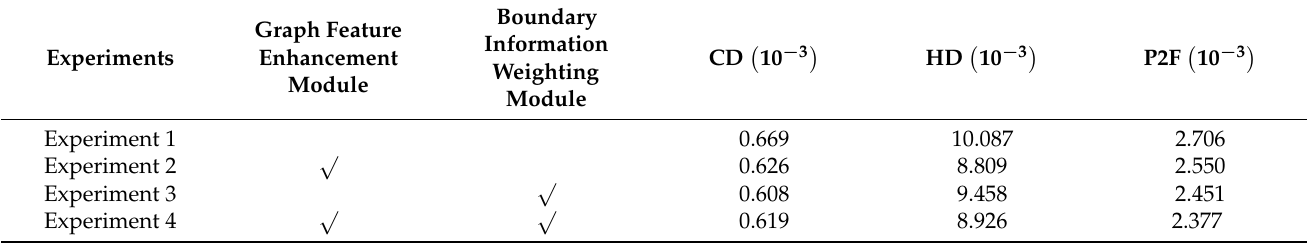
Table 5. Experimental results of ablation of point cloud number from 2048 to 8192.